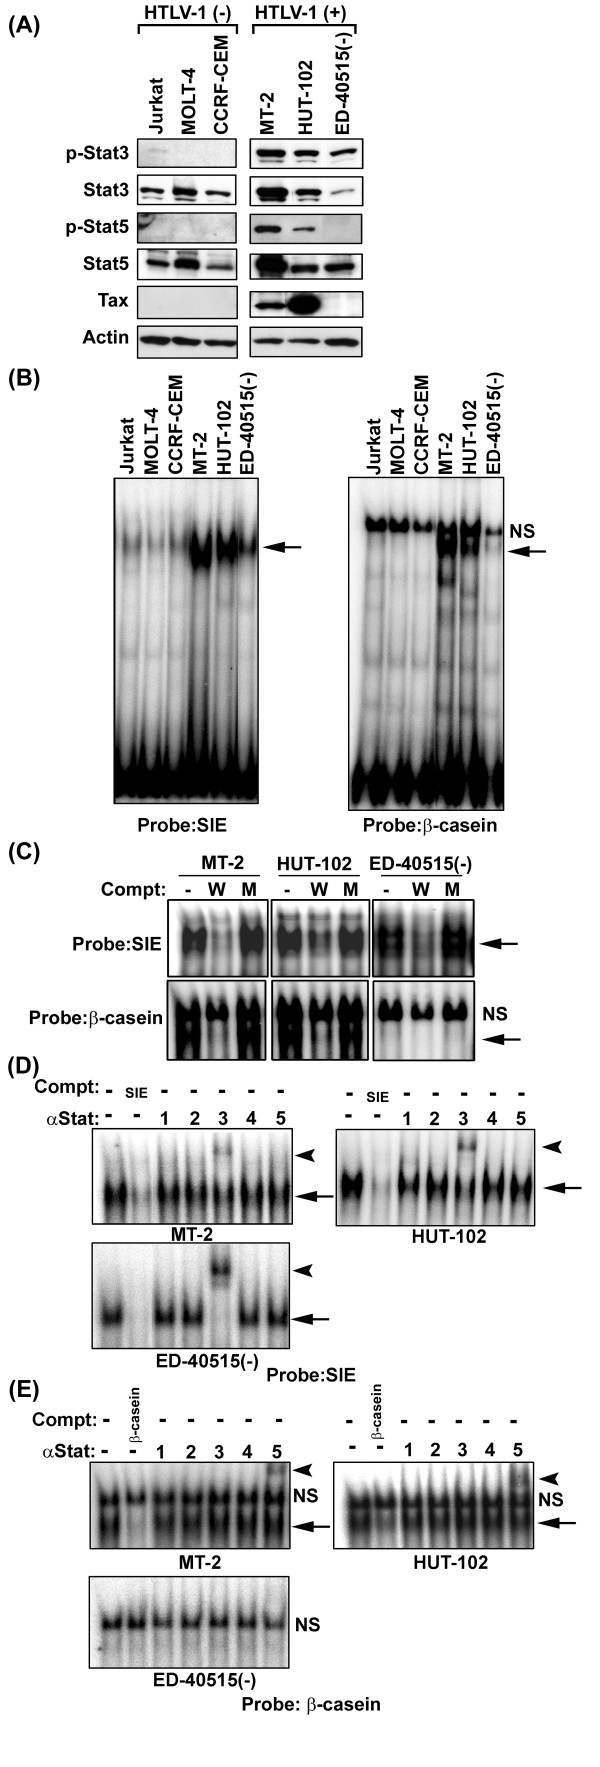
Constitutive activation of Stat3 and Stat5 in HTLV-1-infected T-cell lines. (A) Western blot analysis of cellular lysates prepared from three HTLV-1-negative [HTLV-1 (-)] and three HTLV-1-infected [HTLV-1 (+)] T-cell lines. The blots were probed with anti-phospho-Stat3, anti-Stat3, anti-phospho-Stat5, anti-Stat5 and anti-Tax. Amounts of actin are shown as loading controls. (B) Stat-DNA binding activities in HTLV-1-negative and HTLV-1-infected T-cell lines were detected by EMSA using SIE or β-casein probe. Arrows indicate specific protein-DNA complexes. NS indicates non-specific bands. (C) Competition assay was performed with nuclear extracts of HTLV-1-infected cell lines using 100-fold excess of unlabeled wild type (W) or mutant (M) oligonucleotide as a competitor (upper panels: SIE, lower panels: β-casein). (D and E) Involvement of Stat3 and Stat5 in the formation of SIE- (D) and β-casein- (E) binding complexes in HTLV-1-infected T-cell lines. EMSA was performed with nuclear extracts of the indicated cell lines either in the absence (-) or presence of a specific Stat antibody (αStat: anti-Stat1, Stat2, Stat3, Stat4 and Stat5 antibodies). The supershifted complexes are indicated by arrowheads.